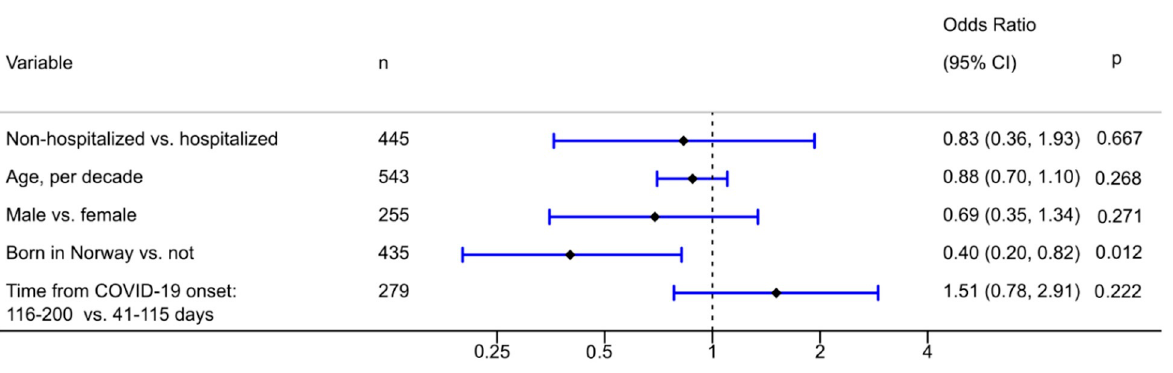
Figure 2. Odds ratios for the symptom-defined PTSD according to DSM-5 scoring with 95% confidence intervals and p -values, multivariable logistic regression analysis ( n = 559).